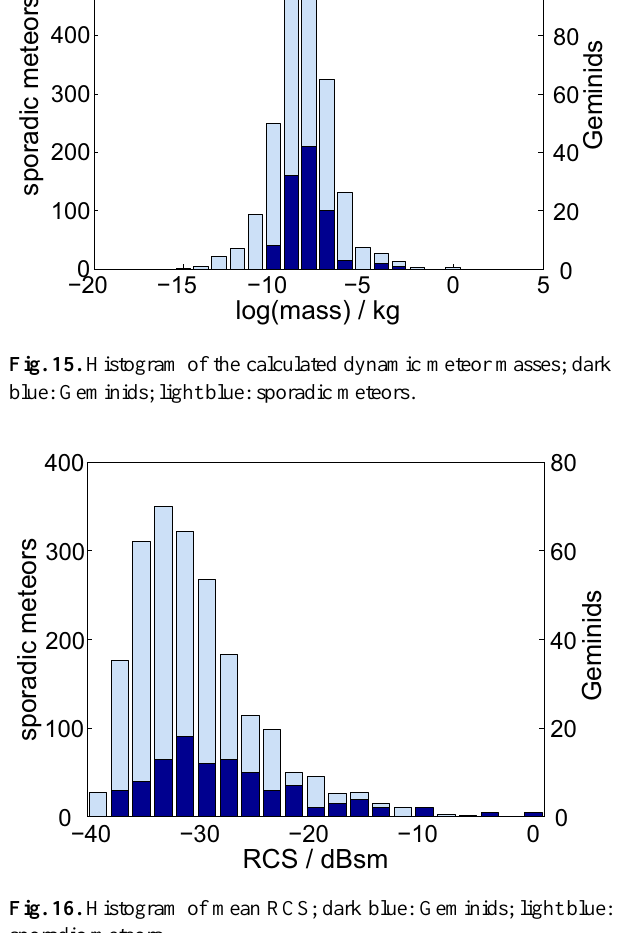
Fig. 16. Histogram of mean RCS; dark blue: Geminids; light blue: sporadic